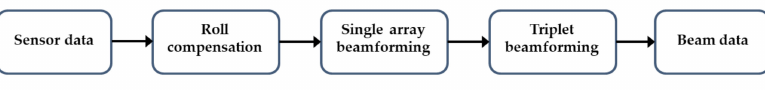
Figure 5. Flow chart of triplet array